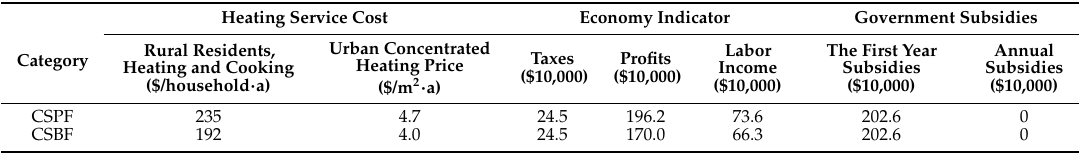
Table 11. Cost of heating service and economic indicators of a CSDF-DHS in the